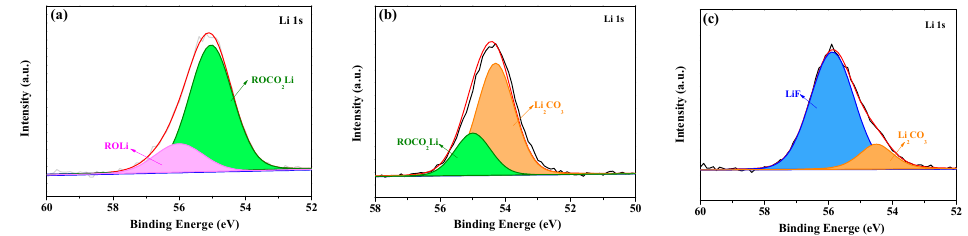
Figure 2. The XPS spectra for Li 1s : ( a ) RT-1D; ( b ) RT-7D; ( c ) 55 °C-7D batteries.